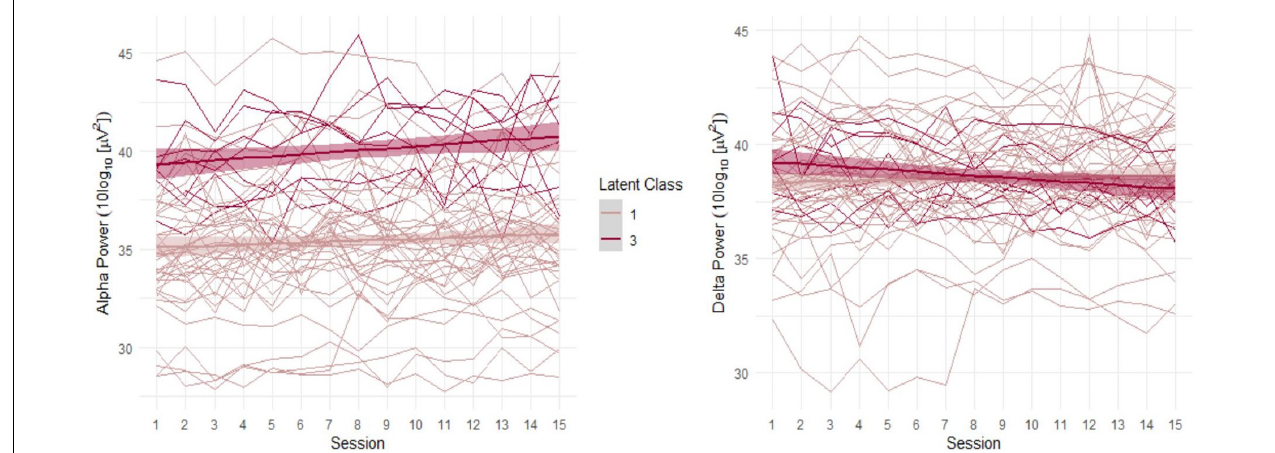
FIGURE 4 | Alpha and delta trajectories in Classes 1 and